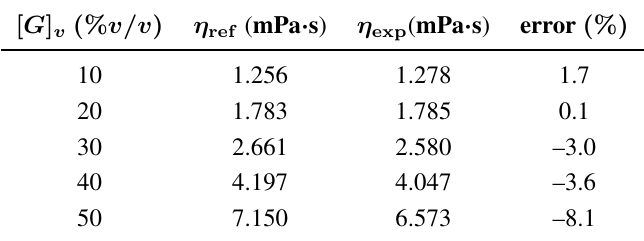
and those extracted from the fits of ref , for mixtures of water and glycerol in the range exp